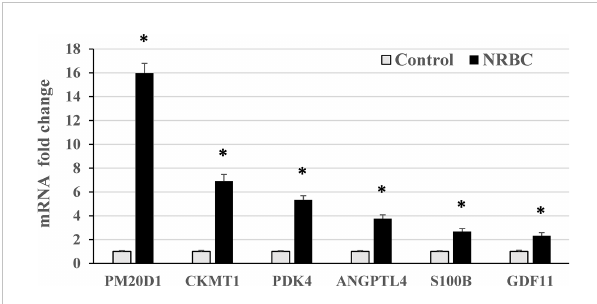
FIGURE 5 RT-PCR validation of genes upregulated by naringenin and beta carotene (NRBC) in RNA sequencing analysis. Adipocytes from three donors with obesity were treated for seven days. mRNA levels were measured using quantitative RT-PCR. Data are expressed as mean ± standard error, *p <